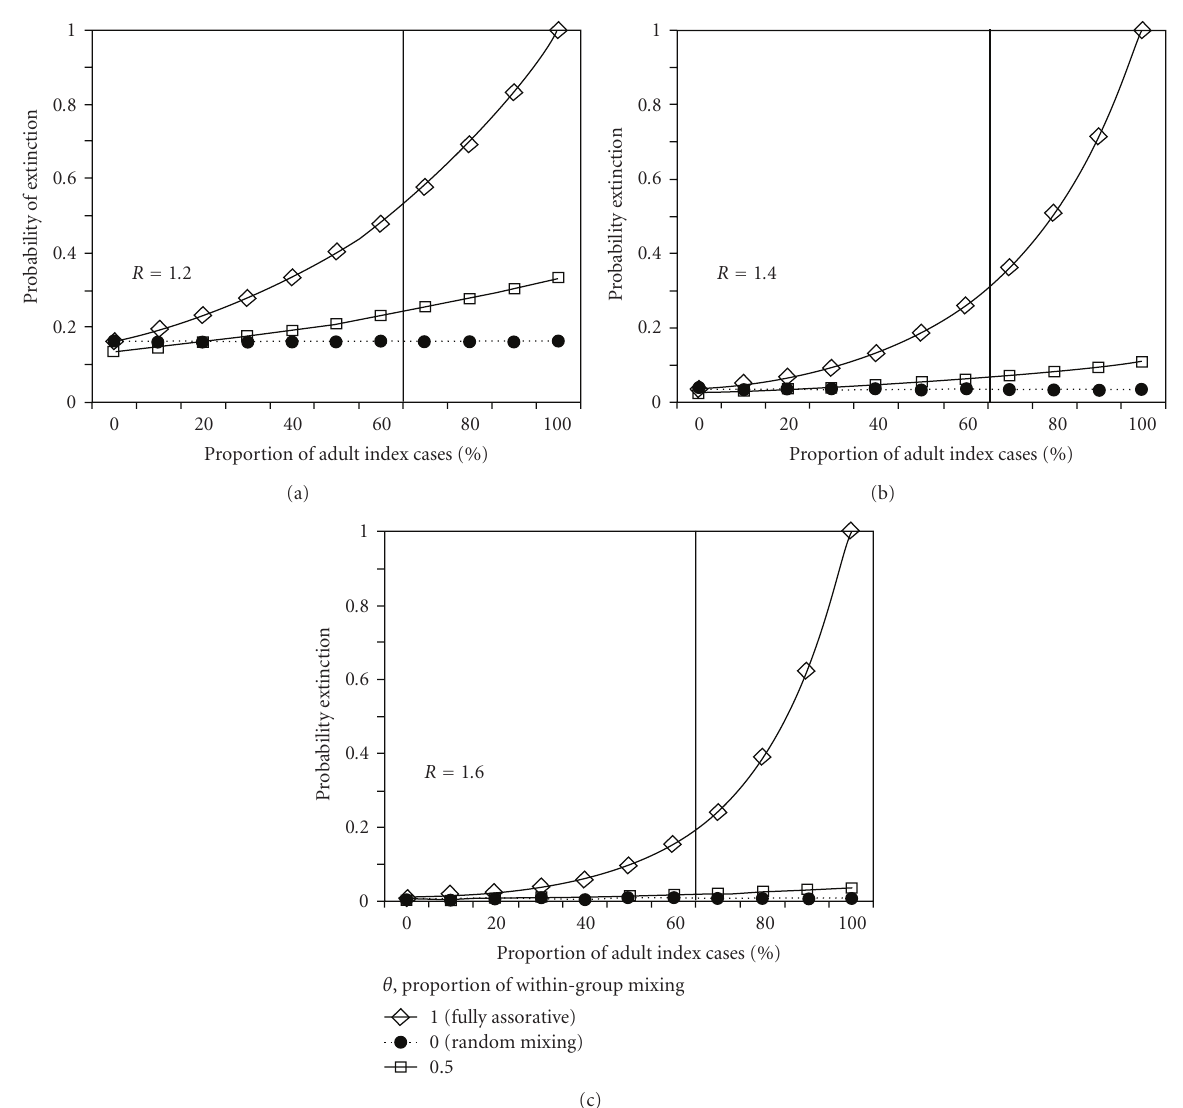
Figure 5: The impact of the age specificity of index cases on the probability of extinction. All panels, (a)–(c), examine the sensitivity of the probability of extinction in a fully susceptible large population given 10 index cases with R = 1 . 2, 1.4 and 1.6, respectively, with di ff erent θ , the proportion of within-group mixing and the proportion of adult index cases. Vertical grey bold line represents the empirically observed proportion of adult imported cases in Japan (i.e., 63.4% were aged < 15 years). The horizontal axis measures the proportion of adult index cases among the total number of 10 index cases. The next-generation matrix, parameterized by Fraser et al. [6] with the dominant eigenvalue R 0 = 1 . 58, is rescaled by multiplying each entry with R/R 0